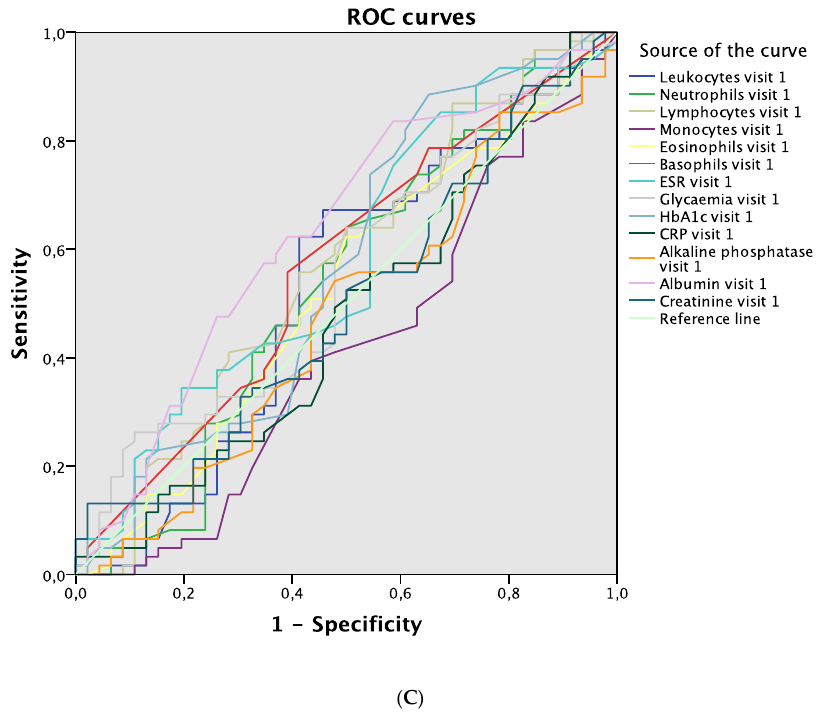
Figure 2. ROC curves. ( A ) Blood parameters in visit 1 associated with complications during 12-month follow-up. ( B ) Blood parameters in visit 1 associated with complications in visit 2. ( C ) Blood parameters in visit 1 associated with complications in visit 3. Abbreviations: ROC, receiver operating curve; ESR, erythrocyte sedimentation rate; HbA1c, glycosylated hemoglobin; CRP, C-reactive protein.